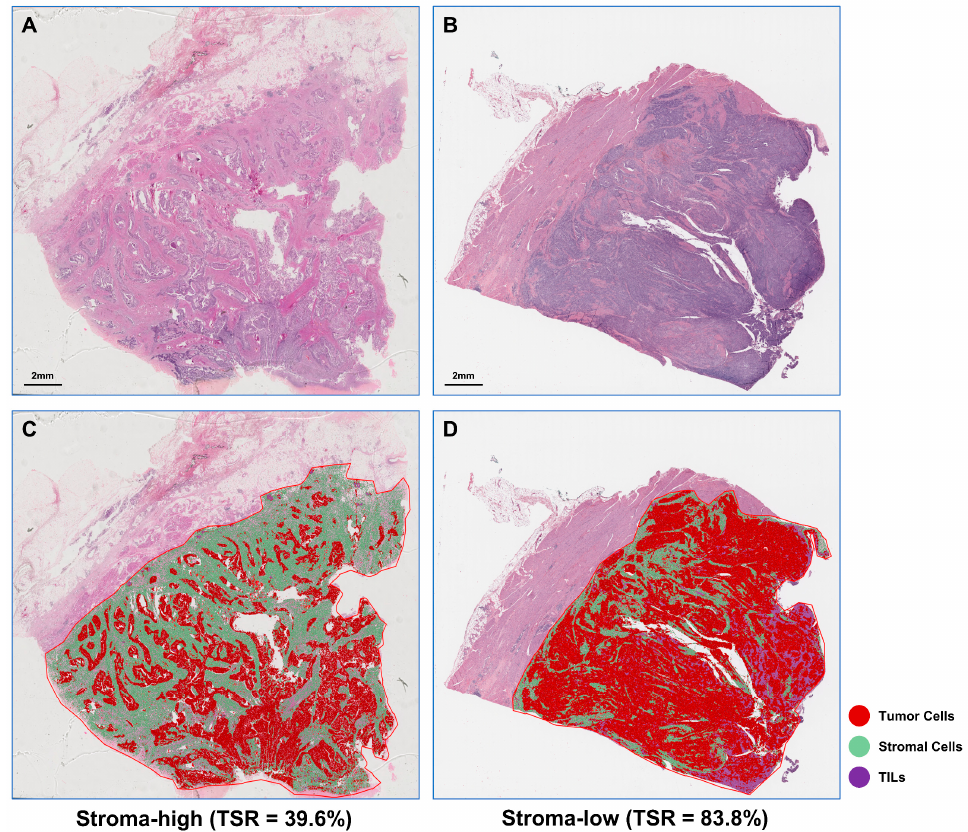
Figure 1. Representative examples of stromal-low ( A ) and stromal-high ( B ) H&E-stained WSI and corresponding machine learning algorithm segmentation results ( C , stromal-low; D , stromal-high). H&E, hematoxylin-and-eosin; WSI, whole slide image; TILs, tumor-infiltrating lymphocytes. For TSR consistency analysis, Figure 2A shows examples of manual annotation by pathologists and automatic segmentation and classification by ML algorithm. Good con- cordance was observed in the classification of tumor and stromal regions between the ML algorithm and pathologist annotation (Figure 2B). There was a high agreement between ML-based and annotated TSR (correlation = 0.911, 95% CI 0.871–0.942). Bland-Altman plot showed decent concordance between TSR calculated by the ML algorithm and that anno- tated by the pathologist, with a mean difference in TSRs of 0.02 (Figure 2C).